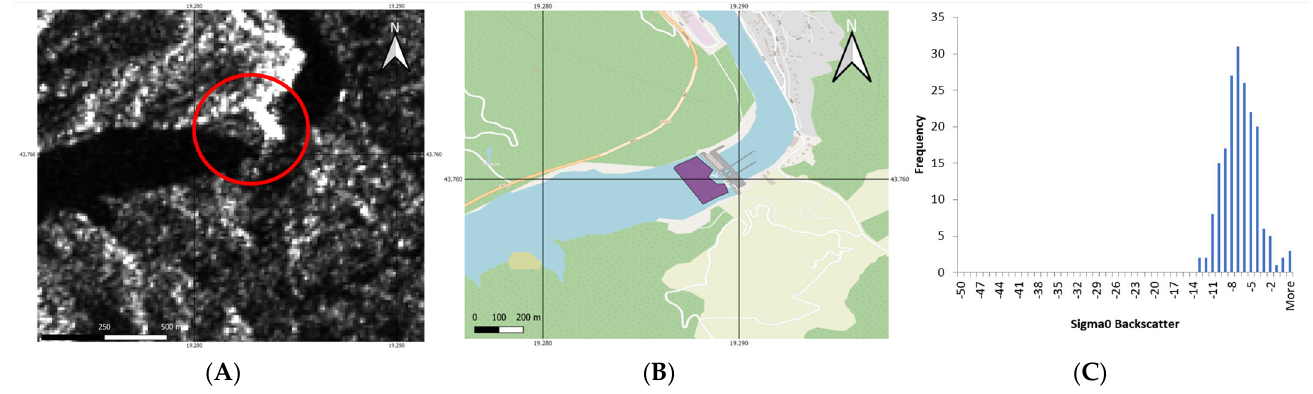
Figure 6. Image from 6 January 2021 in Sentinel-1 VV Channel showing plastic accumulation near River Drina hydroelectric dam, Bosnia & Herzegovina. ( A ) VV intensity with red marker highlighting dam and accumulation, ( B ) Polygon used for histogram, and ( C ) Histogram of pixels in polygon (Sentinel-1, Credits: